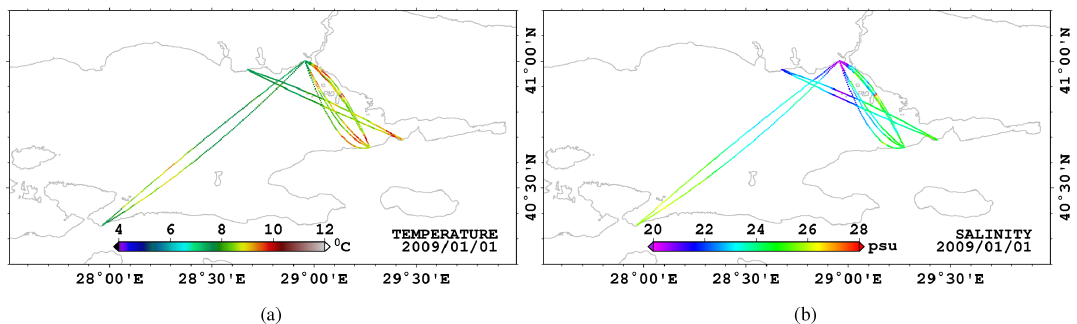
Figure 6. Synthetic (a) temperature and (b) salinity observations on 1 January 2009 sampled from the